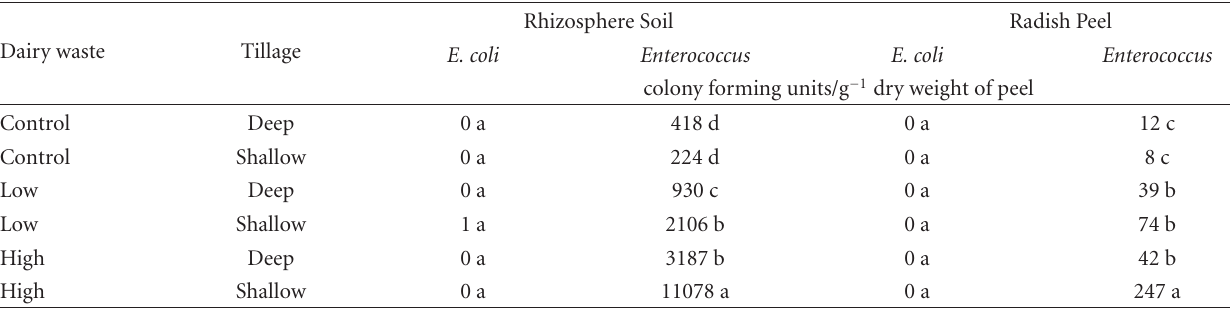
Table 2: Escherichia coli and Enterococcus sp. mean numbers on radish roots ( Raphanus sativus L.) and in rhizosphere soil after 84 days when growing in soil amended with inorganic fertilizer (control) and solid dairy manure with deep (chisel) tillage to a 20 cm depth or shallow (roller) tillage to a 10 cm